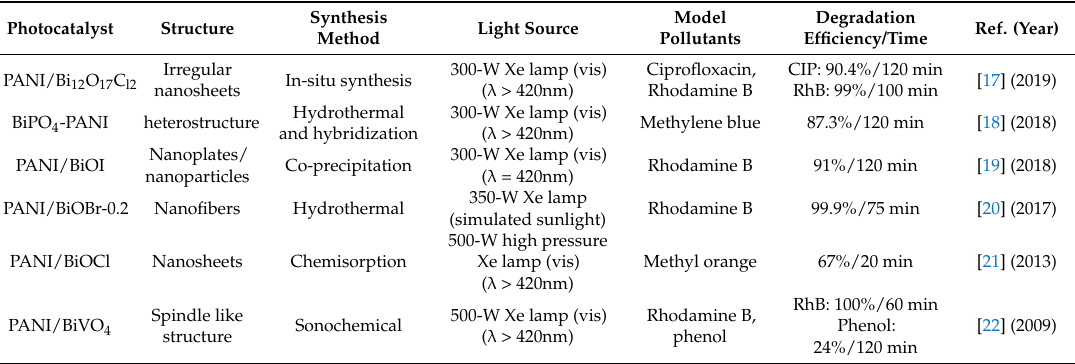
Table 1. Compositions, preparation methods, testing conditions, and photodegradation efficiency of PANI/bismuth-based compounds photocatalysts.